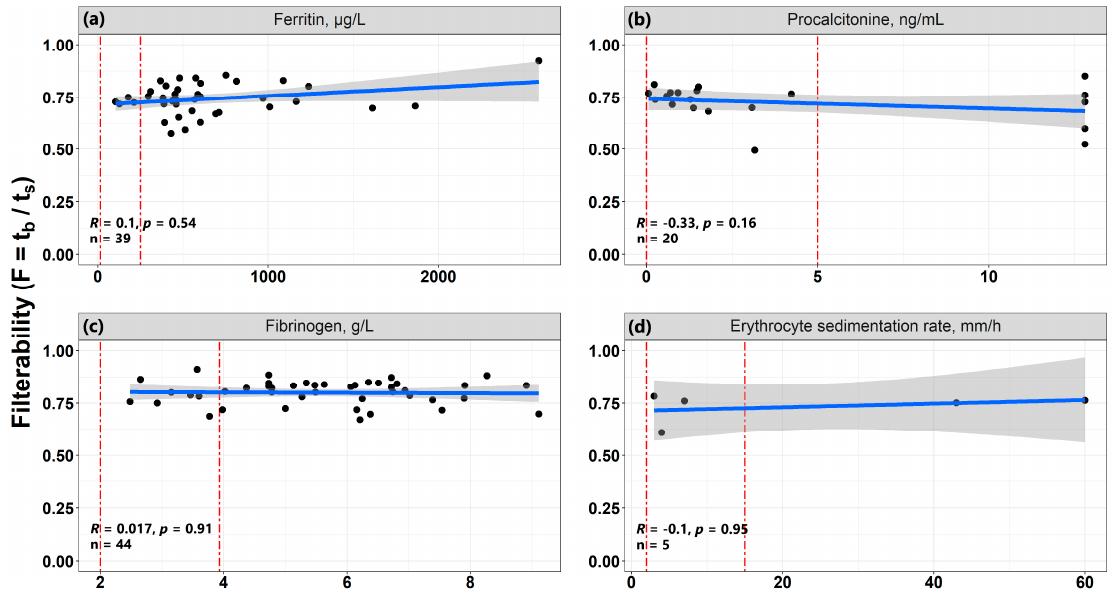
Figure 8. Correlations of RBC filterability in patients with COVID-19 with some markers of inflam- mation: ( a ) Ferritin (n = 39); ( b ) Procalcitonin (n = 20); ( c ) Fibrinogen (n = 44); and ( d ) Erythrocyte sedimentation rate (n = 5). The gray areas are the confidence intervals of the approximating straight line. The vertical red lines show the normal range for each of the